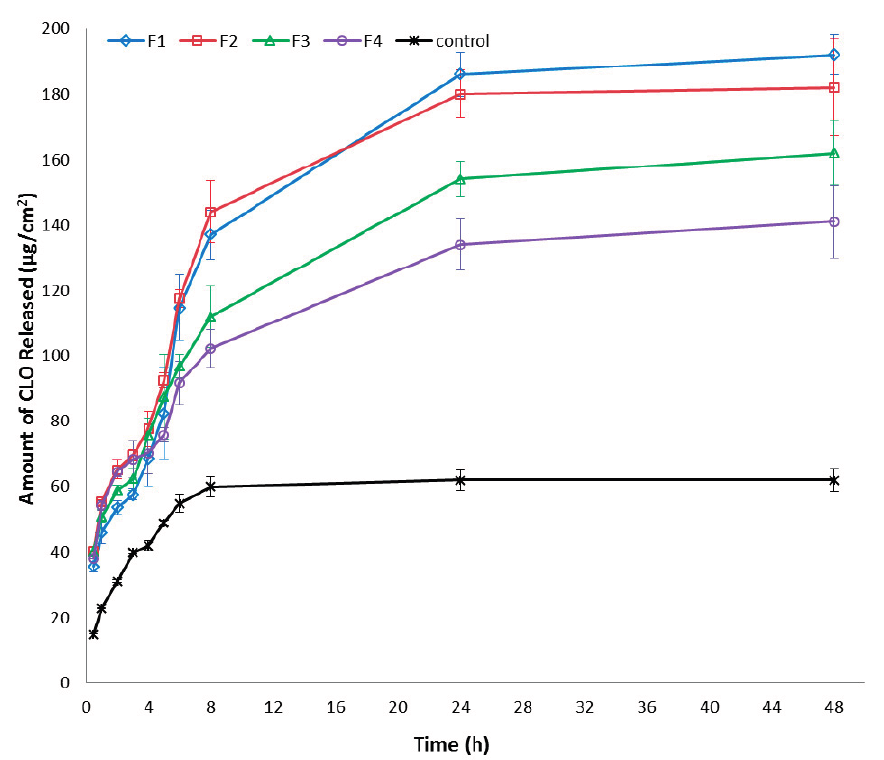
Figure 3. Amount of clotrimazole (CLO) per unit area (µg/cm 2 ) released from different hydrogel formulations compared to commercially available product with clotrimazole